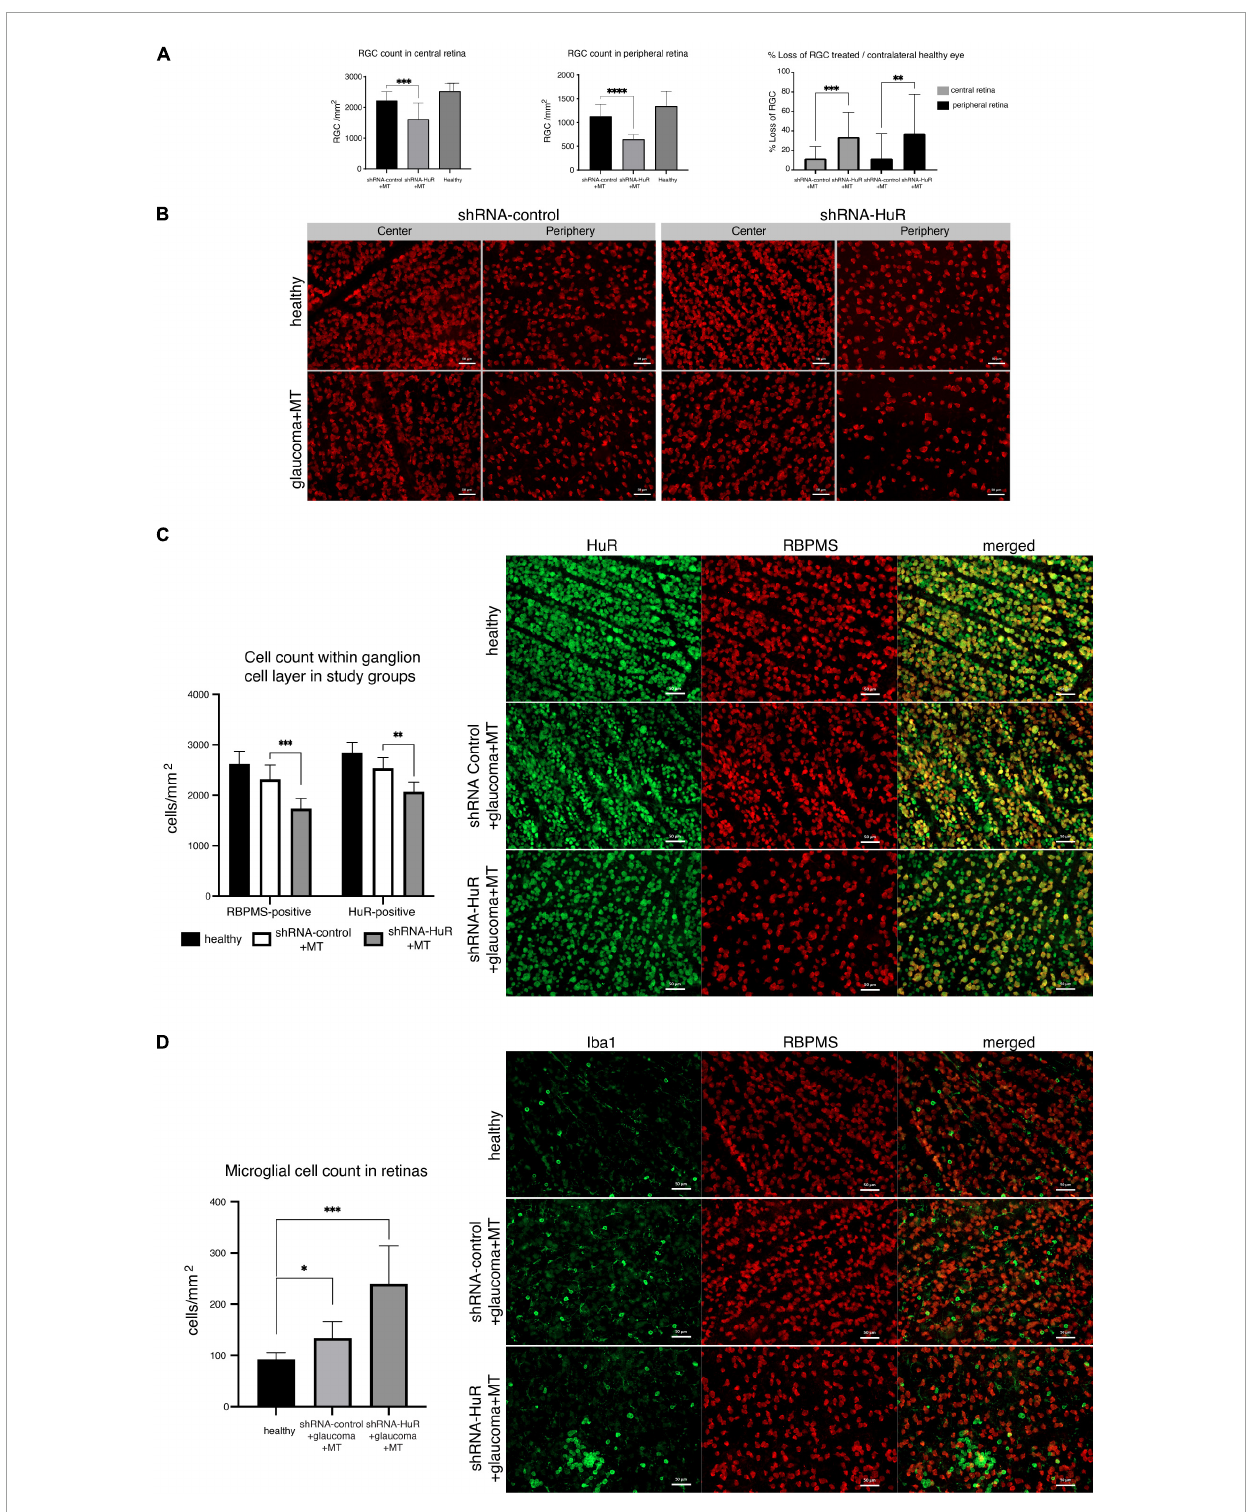
FIGURE6 The exogenous neuroprotection study. (A) RGC counts in corresponding central and peripheral regions of whole-mounted retinas 8 weeks after glaucoma model induction and MT treatment, and % RGC loss in these retinas, n = 8 animals per group, 12 micrographs for each, central and peripheral retina. ∗∗ p < 0.01, ∗∗∗ p < 0.003, and ∗∗∗∗ p < 0.001. (B) RBPMS immunofluorescence staining of the retinal center and periphery 8 weeks after glaucoma model induction and MT treatment. Scale bar = 50 µ m. (C) Immunofluorescence staining for HuR (green) merged with RBPMS (red) and cell quantification in central region of whole-mounted retina. A visible difference in HuR expression is noticeable in the ganglion cell layer of retinal whole-mounts, although the loss of RBPMS-positive cells was greater than HuR-positive cells. ∗∗ p < 0.01, ∗∗∗ p < 0.003. Scale bar = 50 µ m. (D) Immunofluorescence staining for Iba-1 (green) merged with RBPMS (red) and cell quantification in central regions of whole mounted retinas. The infiltration of Iba-1-positive immune cells is particularly pronounced in the shRNA-HuR + MT group, whose microglial cells represented the morphological features of stimulated macrophages. ∗ p < 0.03, ∗∗∗ p < 0.003. Scale bar = 50 µ